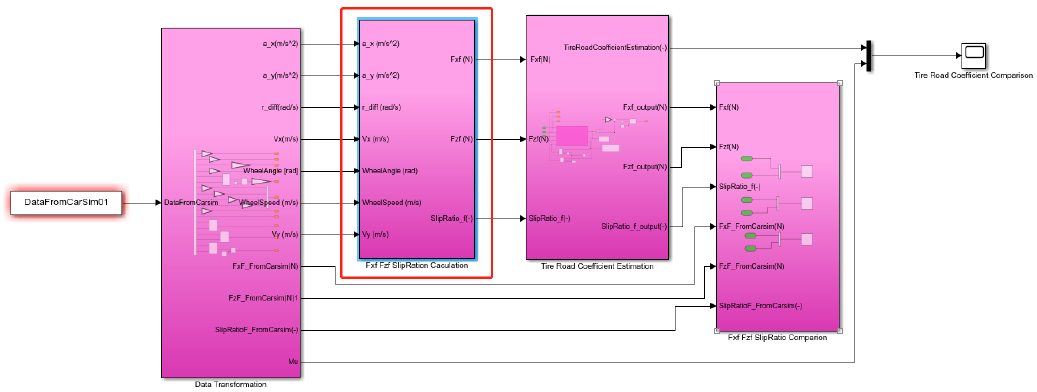
Figure 7. Overall model of pavement friction coefficient estimation algorithm in Simulink environ- ment.